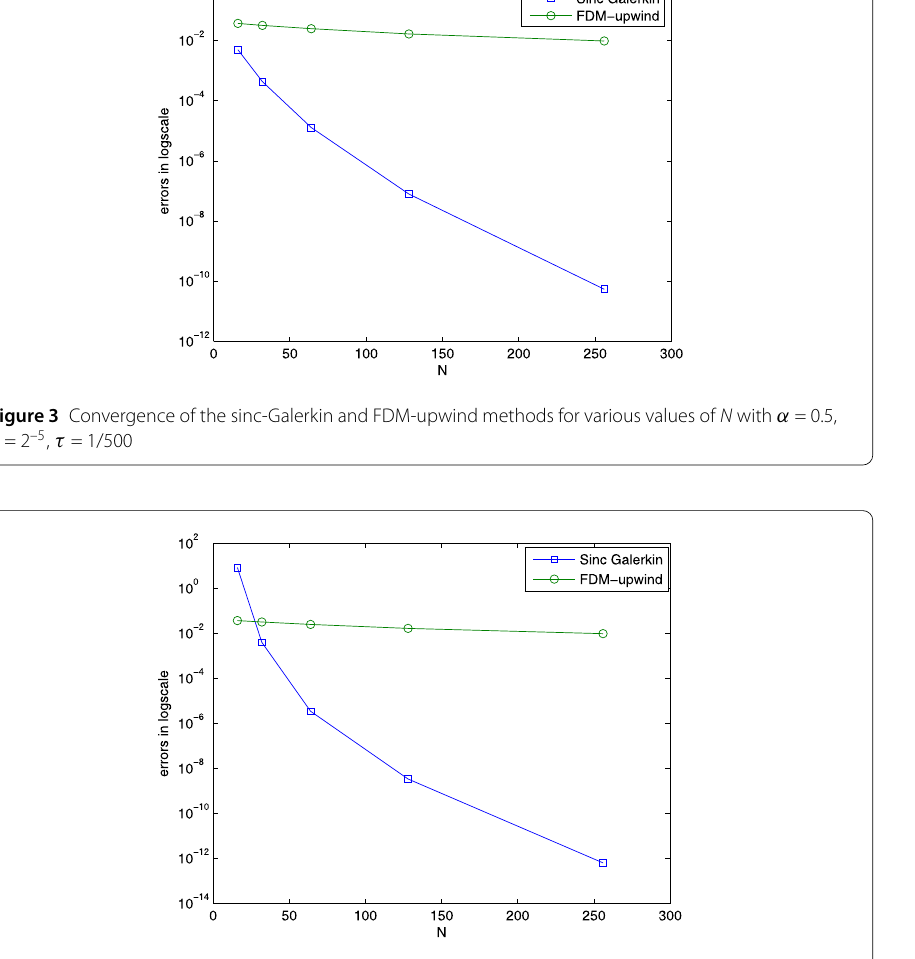
Figure 4 Convergence of the sinc-Galerkin and FDM-upwind methods for various values of N with α = 0.5, (cid:4) = 2 –12 , τ =